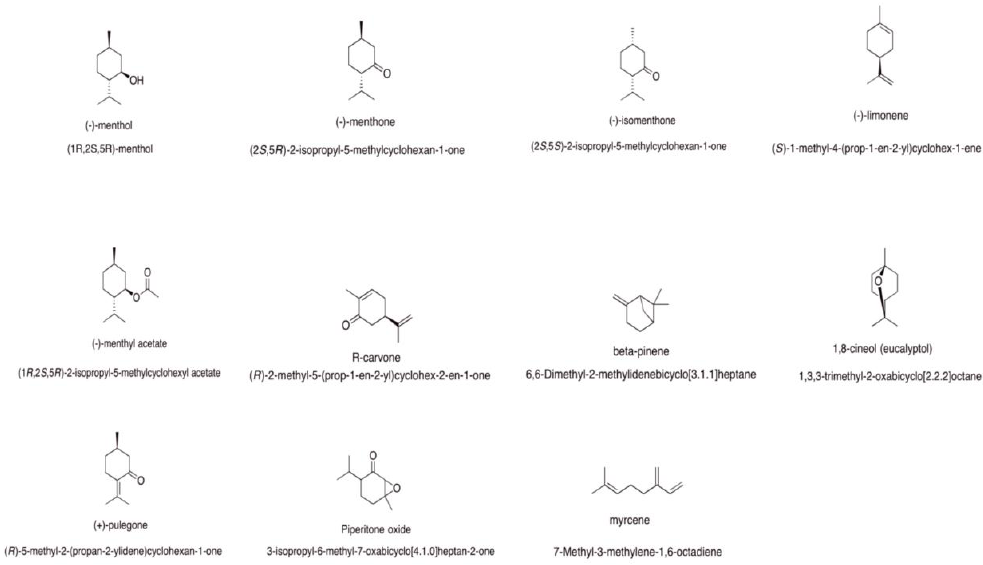
Figure 1. Chemical structures of the main components of Mentha spp. essential oils (EOs).